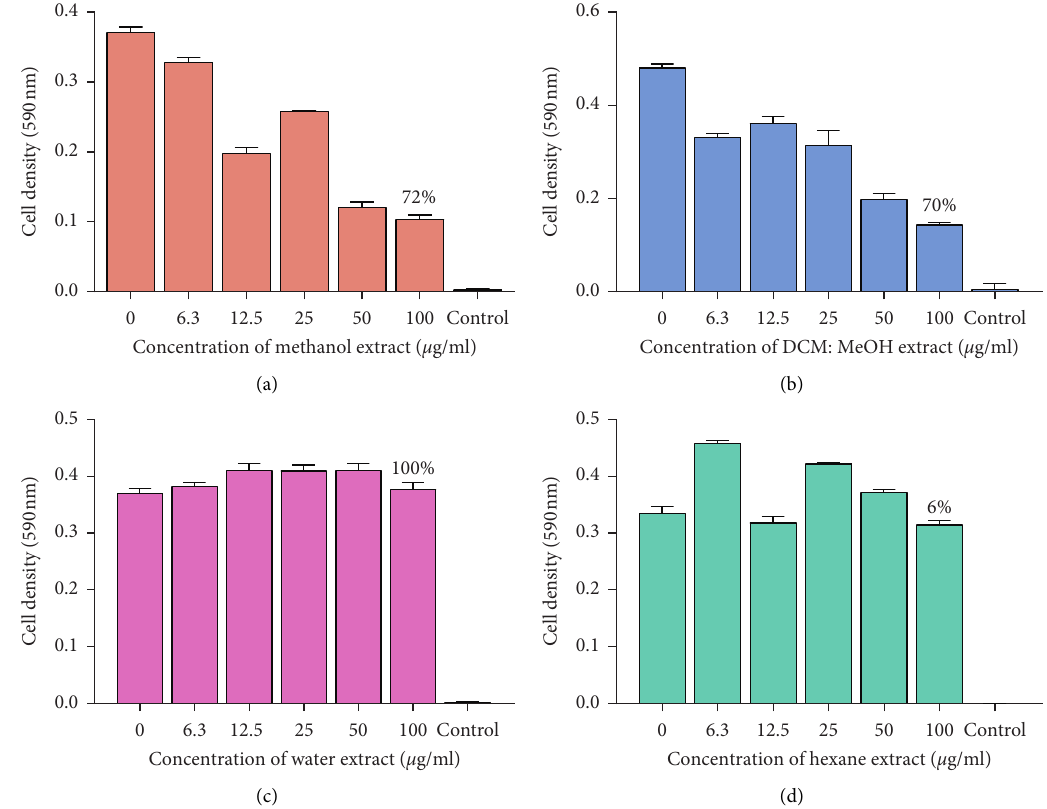
Figure 5: The effects of extracts of pods of P. thonningii against P. aeruginosa : (a) effect of methanol extract, (b) effect of DCM :MeOH extract, (c) effect of water extract, and (d) effect of hexane extract. Concentrations of extract ranged from 6.3 μ g/mL to 100 μ g/mL. Values are in mean cell density at 590nm wavelength ± the standard deviation. N �